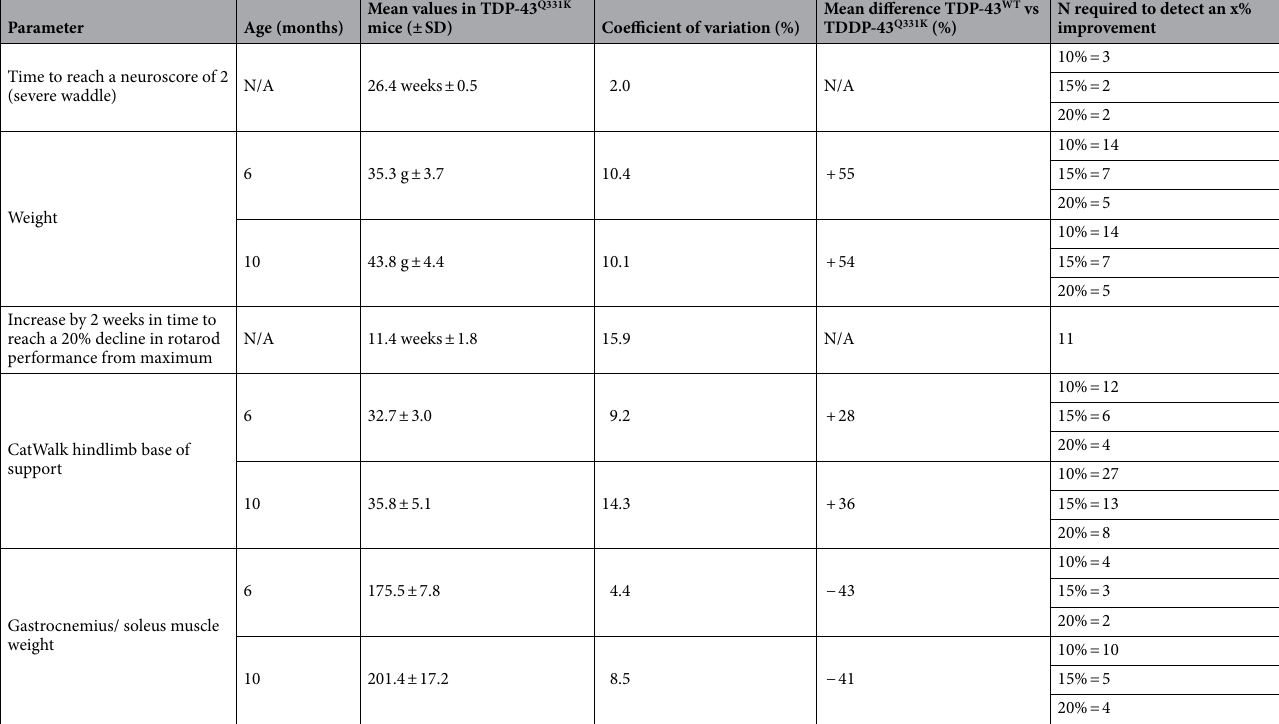
Table 1. Numbers of mice/group required for investigation of each parameter. All power analyses are based on detecting a power of 80% in females, using the highest standard deviation (SD) from the relevant